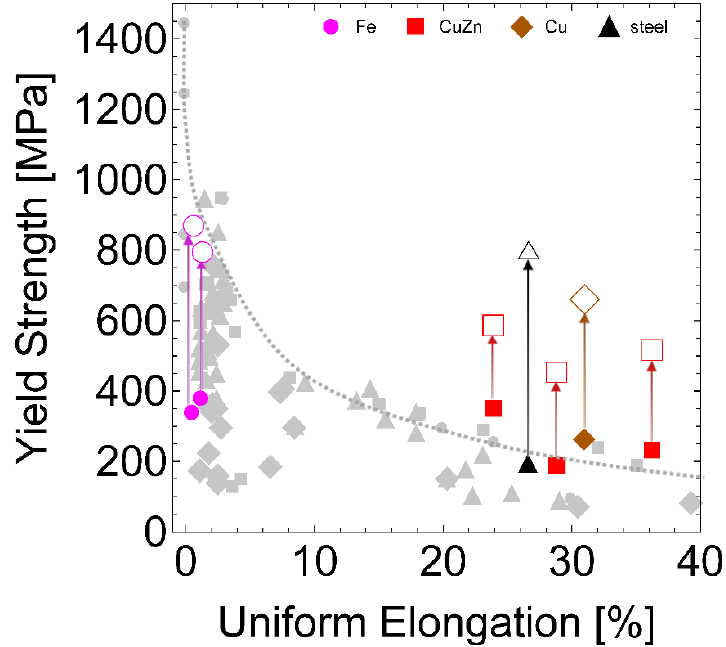
Figure 4. Tensile data existing for gradient grain structures are depicted for the iron SMAT in this work (magenta circles), Cu-Zn alloys [33] (red squares), copper [5] (orange diamond); steel [25] (black triangle). Literature values for bulk structures in the same materials are shown in gray (iron: gray circles [34], steel: grey triangles [25] and references therein, Cu-Zn alloys: grey squares [33] and references therein, copper: gray diamonds [31,35–40]). The strength ductility tradeoff is illustrated by the dotted line. The surface strength for each gradient structure is depicted with an open symbol of the same color and at the same elongation point, connected by a gradient